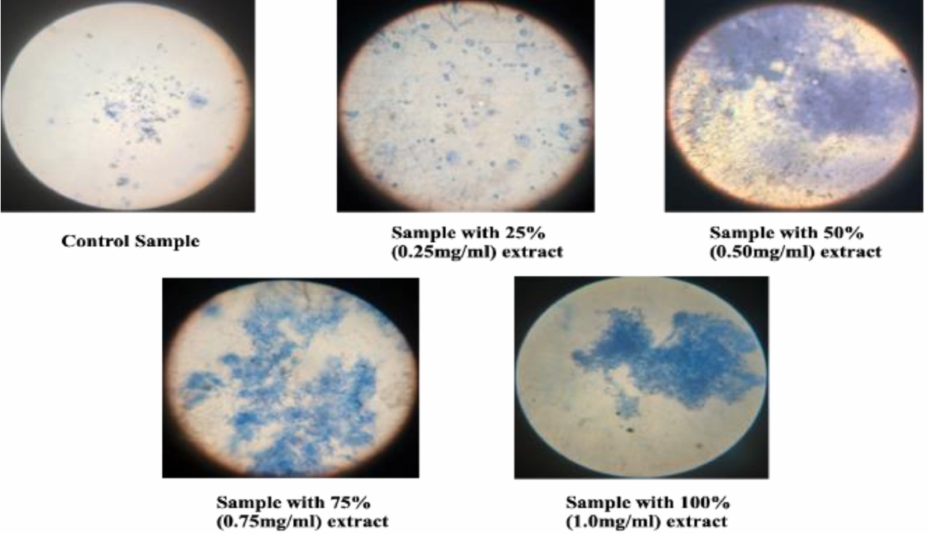
Figure 12. Antiproliferative activity as observed in the microscope (after staining with methylene